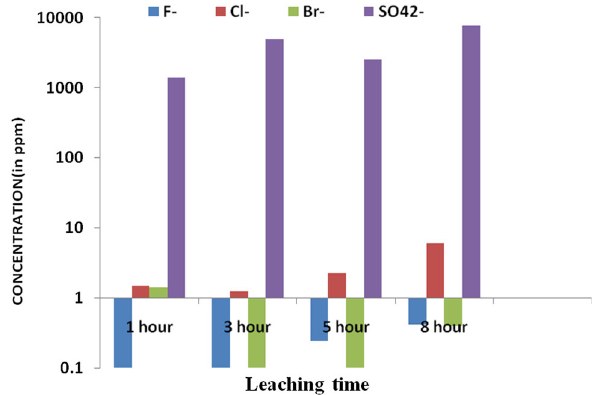
Fig. 20 Change in concentration (in ppm) of anions in aqueous leachates of Ledo coal (LC-60A) with leaching time (in hour) at 65 (cid:3) C